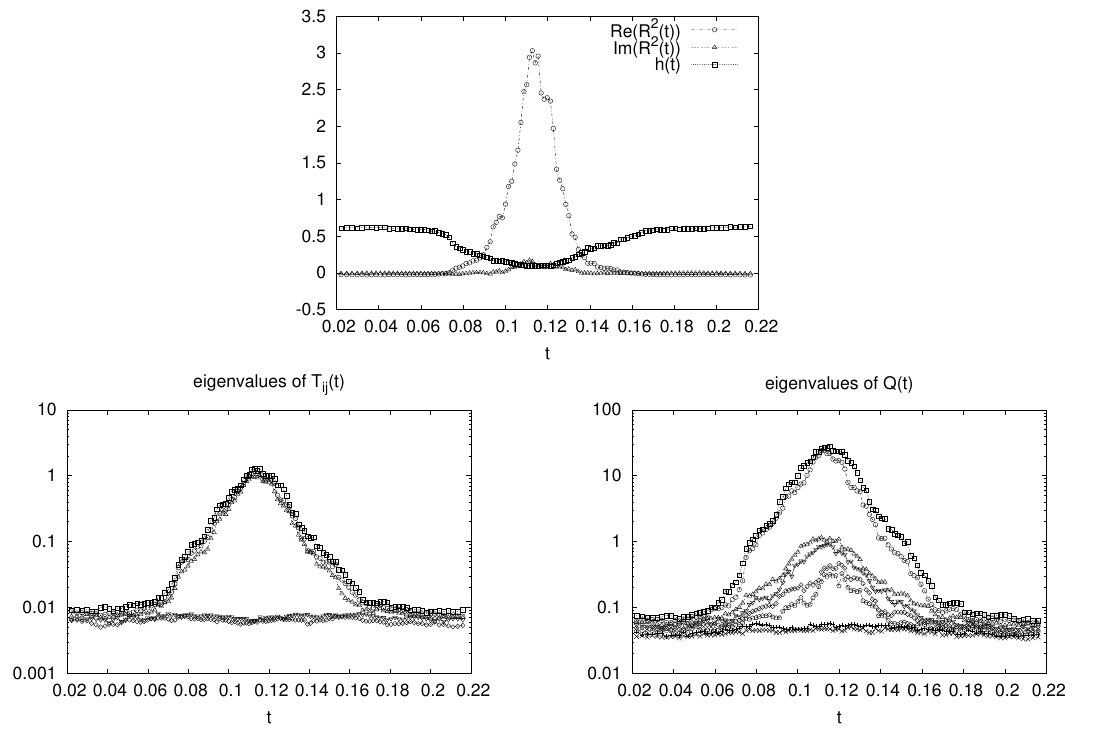
Figure 2 . Results for ( s, k ) = (0 . 0076 , 0 . 5038), N = 128, κ = 0 . 0037, β = 32, n = 16 are shown. (Top) The real and imaginary parts of R 2 ( t ) are plotted against t . The Hermiticity norm h ( t ) of the matrix ¯ A i ( t ) is also plotted. (Bottom-Left) The five eigenvalues of the moment of inertia tensor are plotted against t in the log scale. (Bottom-Right) The eight largest eigenvalues of the matrix Q ( t ) are plotted against t in the log